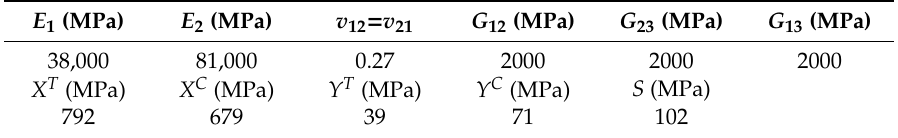
Table 2. Material Properties of the GFRP Strut Used for the Simulation.